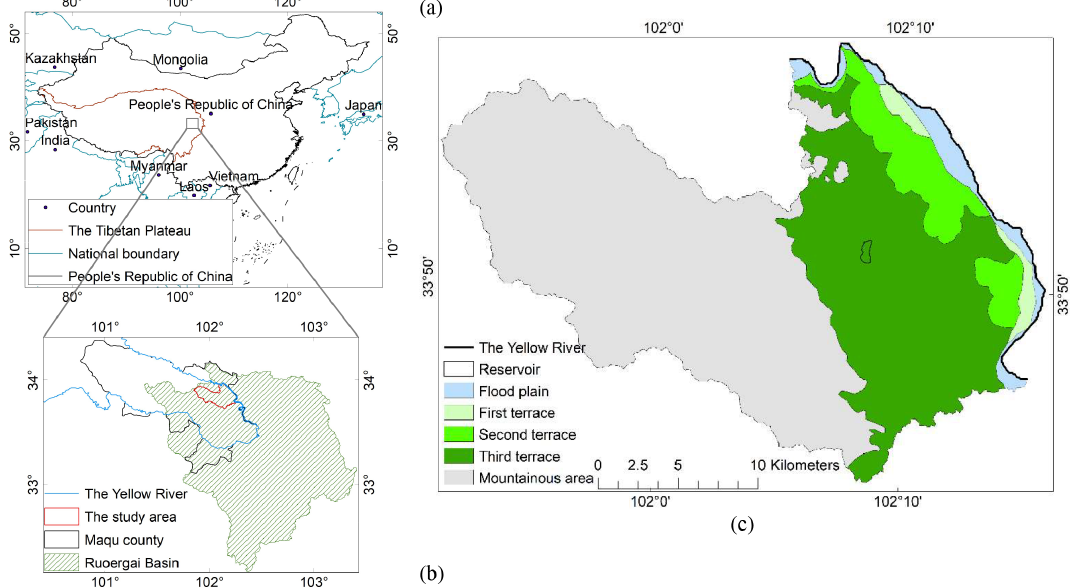
Figure 1. The geographical location of Maqu catchment, Maqu County, and Ruoergai basin on the TP and geomorphologic map: (a) the geographical location and boundary of the TP (Zhang et al., 2014a, b); (b) the geographical location of the Maqu catchment, Maqu County, and Ruoergai basin (Li and Gao, 2019); (c) the geomorphologic map of Maqu